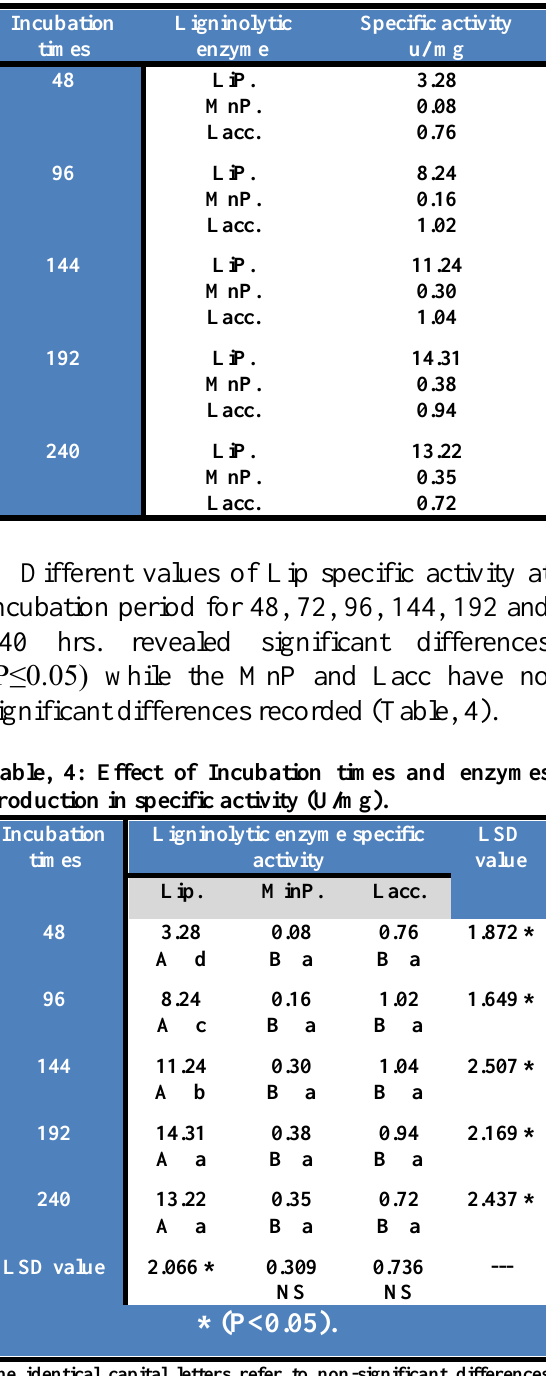
Table, 3: ligninolytic enzymes production harvested in different time interval.